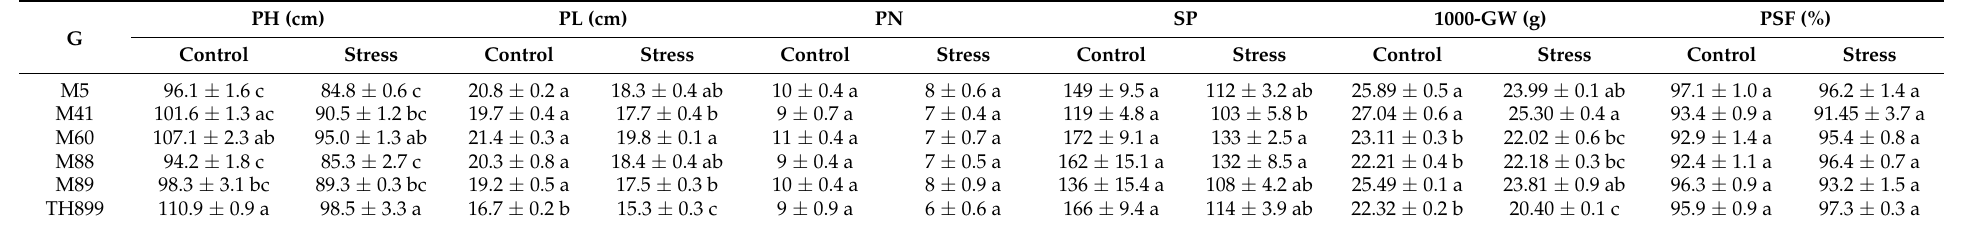
Table 5. Yield components of mutant lines under control and saline–alkaline stress conditions in